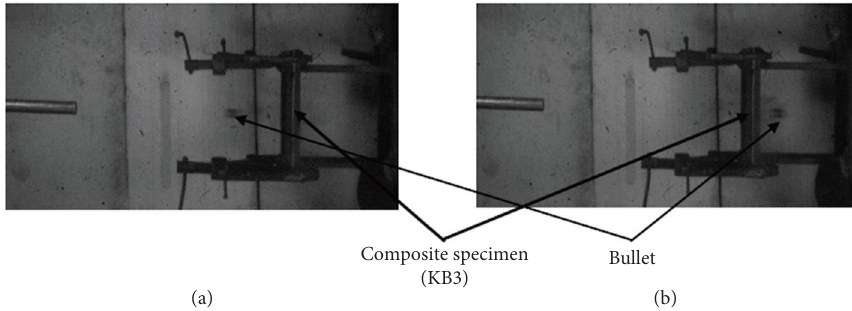
Figure 9: KB3 placed for testing: (a) KB3 before the impact and (b) KB3 bullet after the impact. Table 4: Absorbed energy of the composite samples.